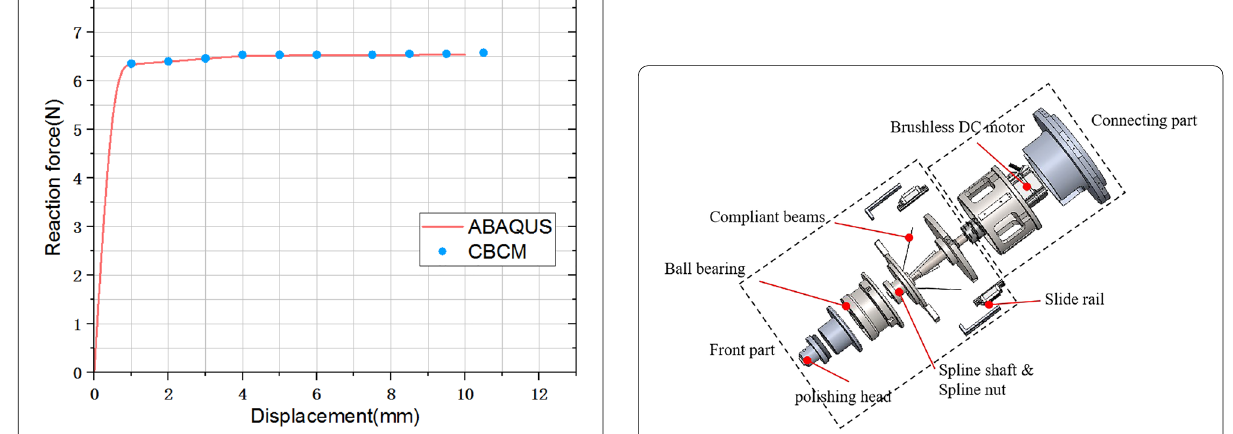
Figure 5 CBCM/ABAQUS Comparison Figure 6 Exploded view of the